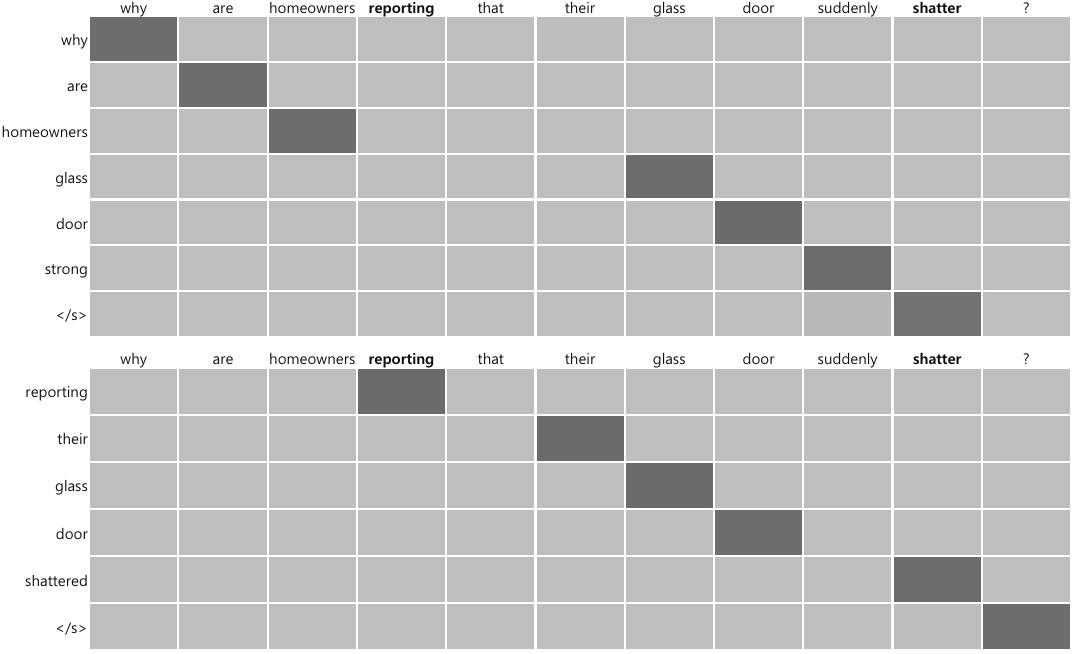
Figure 3. The attention weights on Sentence 3 in Table